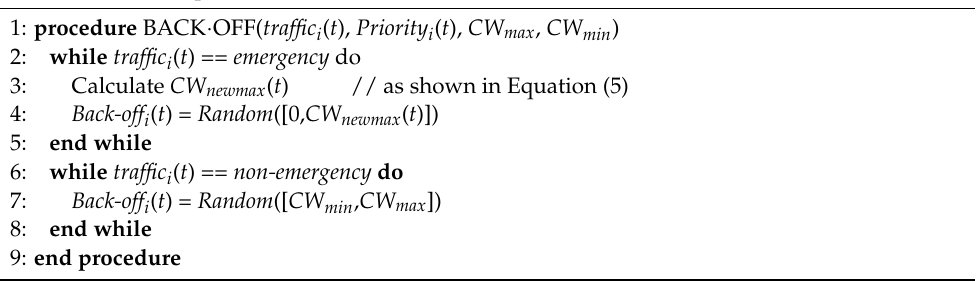
Algorithm 3: This procedure calculates the Back-off value for a node